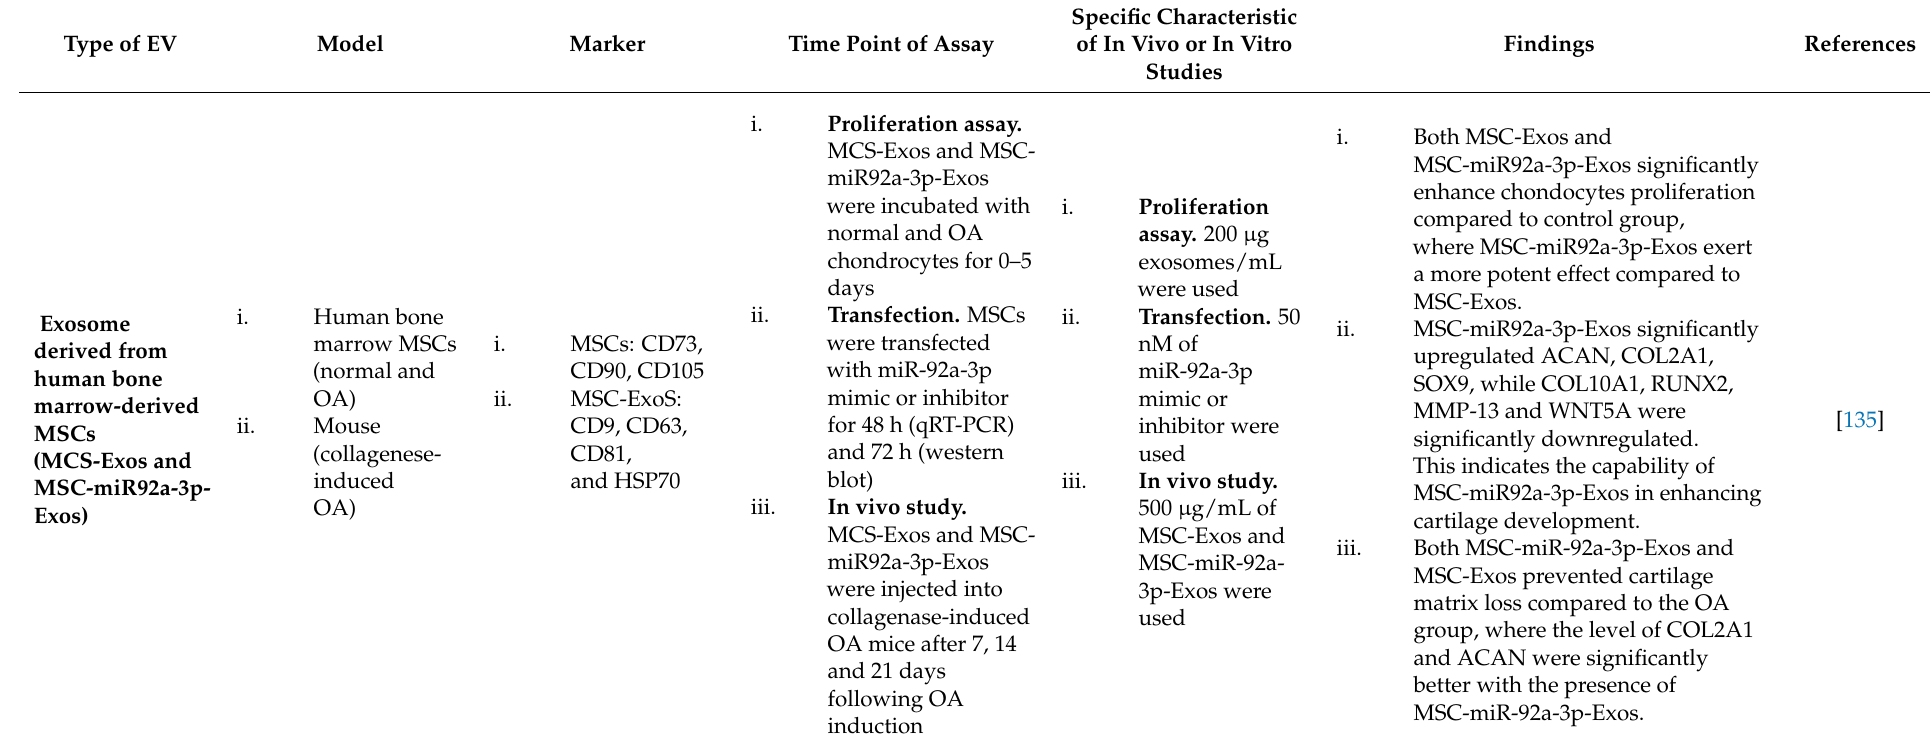
Table 3. Therapeutic evidence of MSC-derived EV in OA